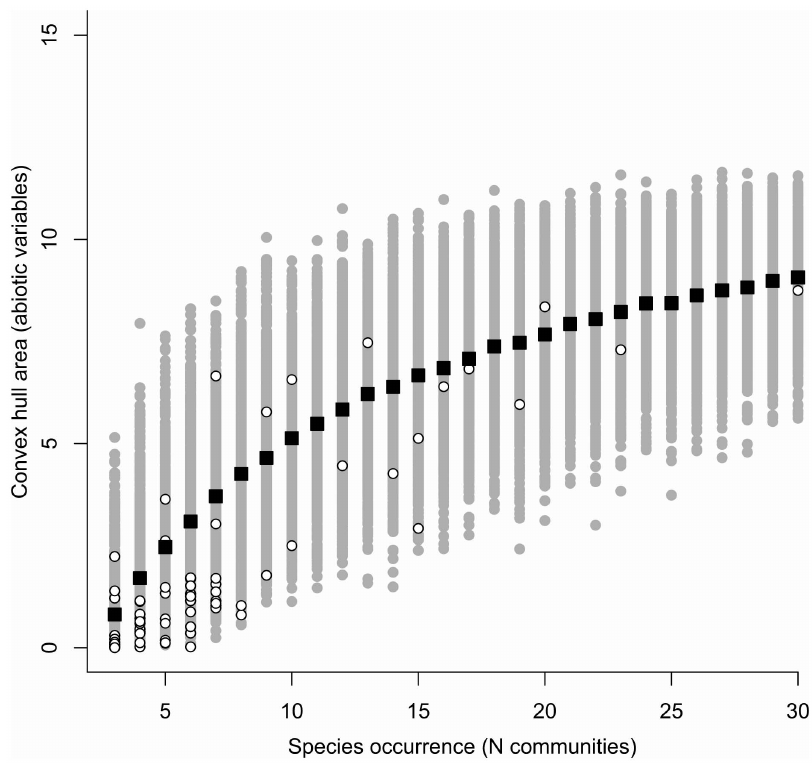
Figure 1. Convex hull area size of 76 species of Bignonieae from their abiotic variables. Convex hull were estimated from the two PC axes scores. Species occurrence indicates the number of communities in which a species was recorded. Open circles represent the observed values of convex hull. Grey circles represent the estimated null distribution of convex hull (see text). Black squares show the mean of the null distribution calculated from each species occurrence number.